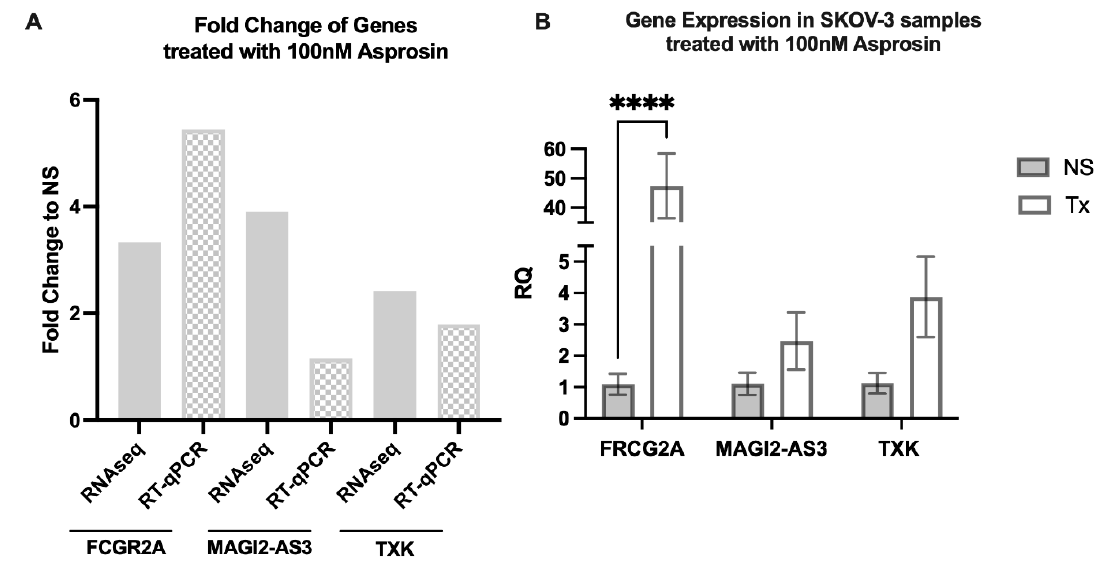
Figure 6. Validation of RNA seq data. Expression of FRCG2A, MAGI2-AS3 and TXK in SKOV-3 cells following treatment (Tx) with 100 nM asprosin at 4 h. ( A ) Gene expression shown as fold change (FC) in gene expression following treatment (100 nM asprosin) at 4 h compared to RNA seq fold increase. ( B ) RT-qPCR analysis of cells treated (Tx) with asprosin (100 nM) versus no supple- ment (NS) showing an increase in trend for all genes, with a significant change seen for FRCG2A, **** p < 0.0001.